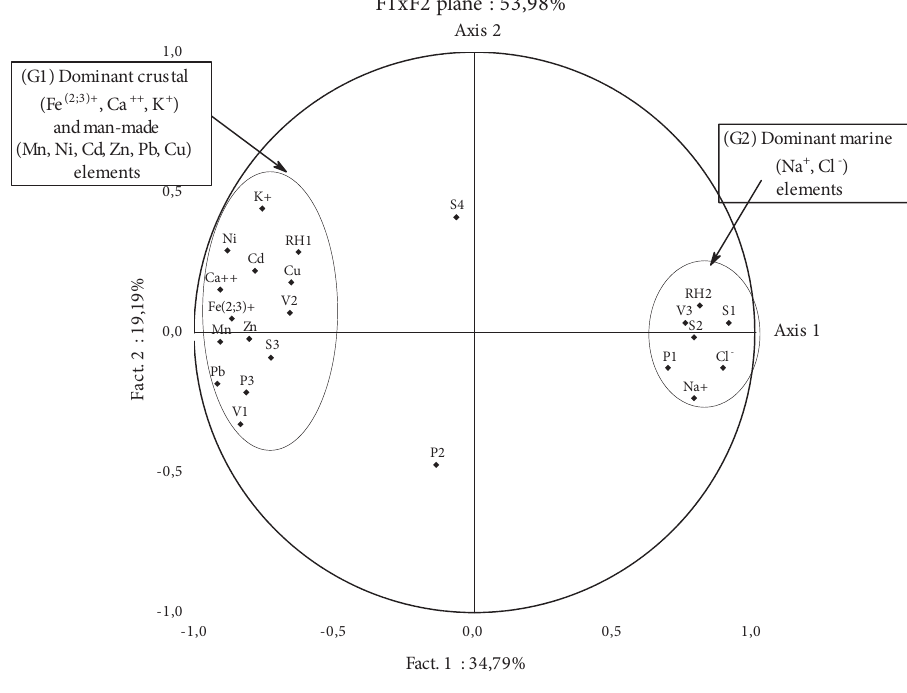
Figure 12. Distribution of biweekly fluxes constituents of particle deposition in the correlation circle (for S14 site; r = 0.42 for p < 0.05 and n =